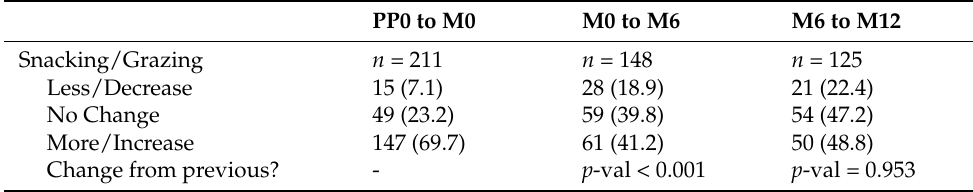
Table 1. Eating pattern changes in consecutive survey time points (PP0 to M0, M0 to M6, M6 to M12); McNemar–Bowker test p -values for whether the current six-month distribution of decrease/no change/increase is different from previous